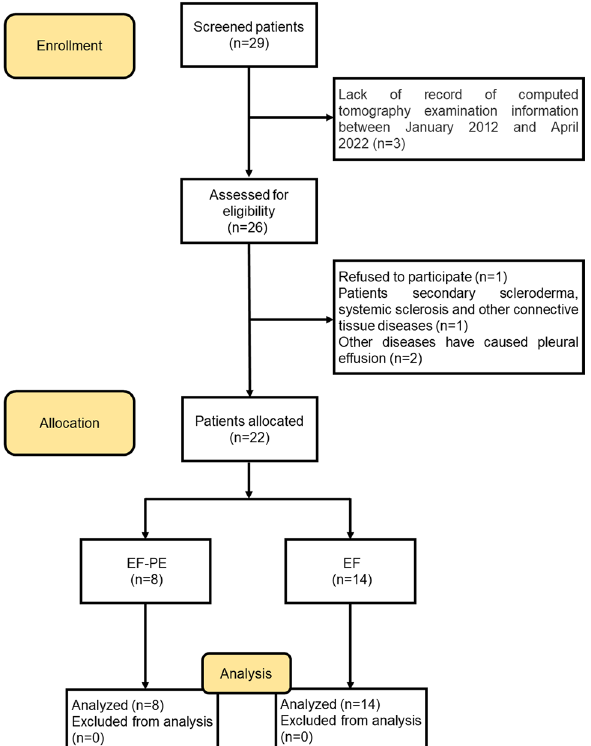
Figure 1. Flow diagram of the